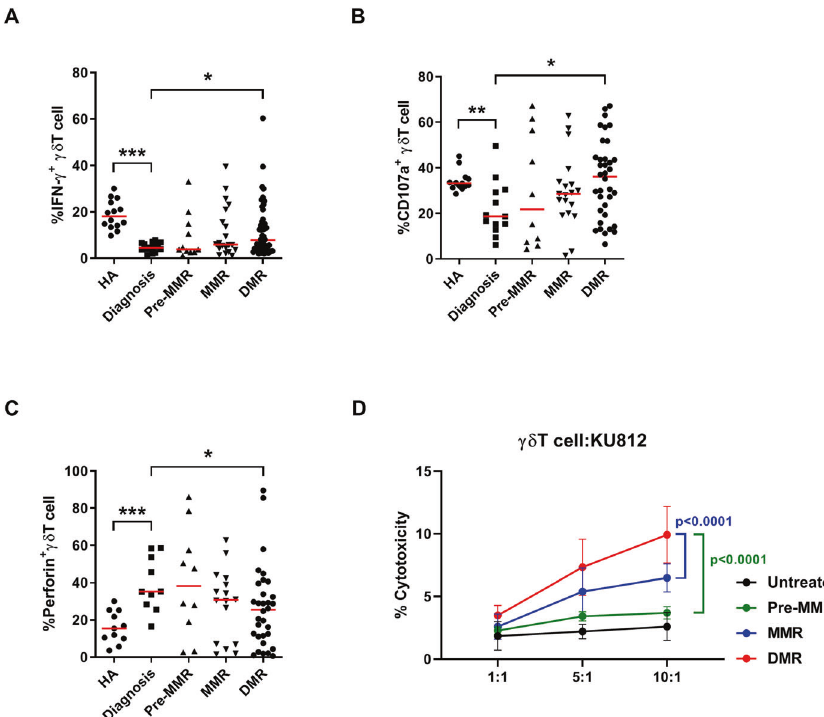
Fig. 4 γδ T cells isolated from TKI-treated CML patients showed broad reactivities to BCR-ABL-inactivated CML cells. The percentages of γδ T cells expressing A intracellular IFN- γ , B perforin, and C surface CD107a were determined using fl ow cytometric analysis. Red bars denote the median. Data comparison was performed by the Mann-Whitney U test and paired t test. D The cytolytic activity of γδ T cells isolated from patients on pre-MMR, MMR, and DMR was performed. KU812 cells were untreated or treated with BCR-ABL -speci fi c siRNA and co-cultured with γδ T at the indicated effector-to-target (E:T) ratios. One-way ANOVA was used for comparison between groups, and Bonferroni ’ s post hoc test was used to compare selected pairs. Statistically signi fi cant differences between the groups were marked with asterisks. Data were presented in mean ± SD of three patients. Statistical signi fi cance was de fi ned by * p < 0.05, ** p < 0.01, and *** p <